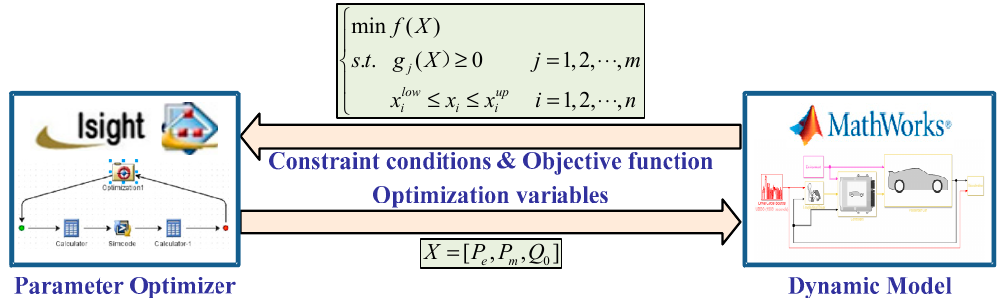
Figure 7. Integrated optimization platform based on Isight.